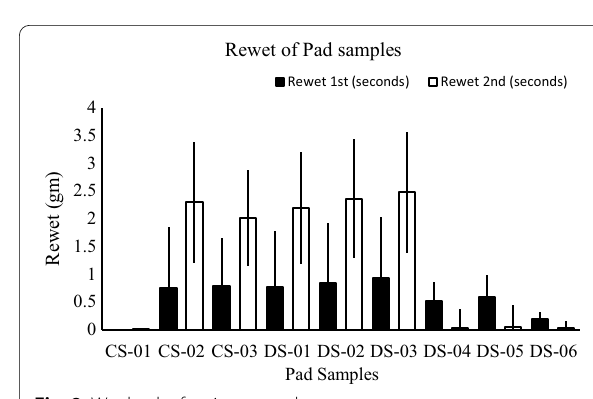
Fig. 8 Wet back of various